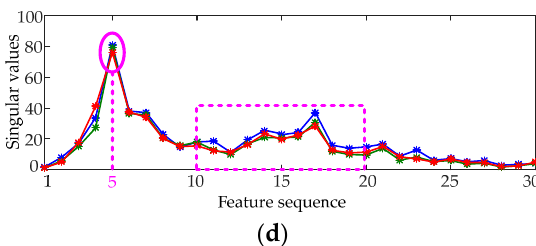
Figure 11. The LSV feature vectors of normal and fault signals. ( a ) Normal condition; ( b ) Fault I; ( c ) Fault II; ( d ) Fault III.